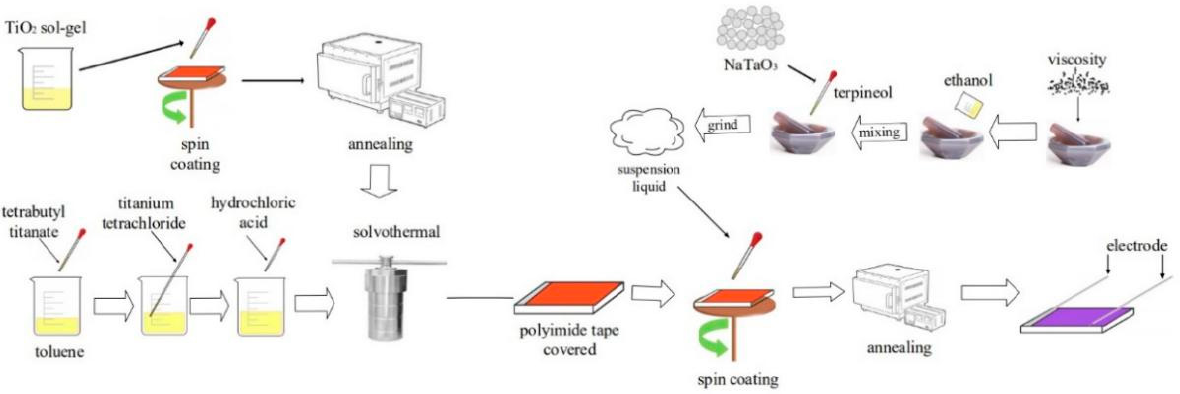
Figure 1. The flow chart of the synthesis pathway.